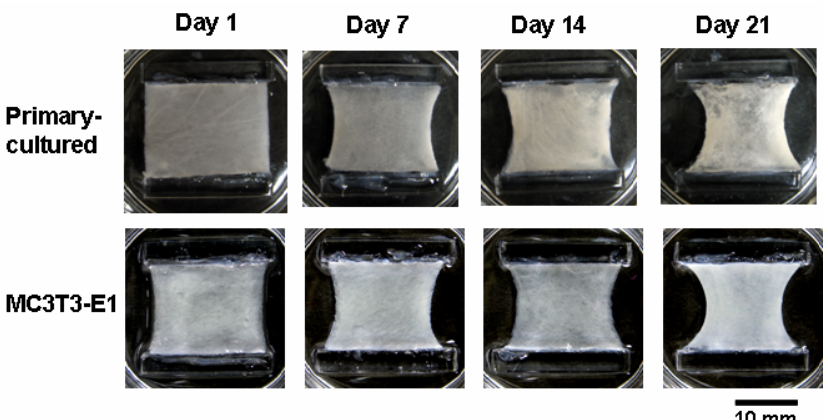
Fig. 5 Close-up photographic images of the tissue-engineered bones, showing changes in the appearance of the tissue-engineered bones with the rat primary-cultured osteoblasts cells or MC3T3-E1 cells with days in